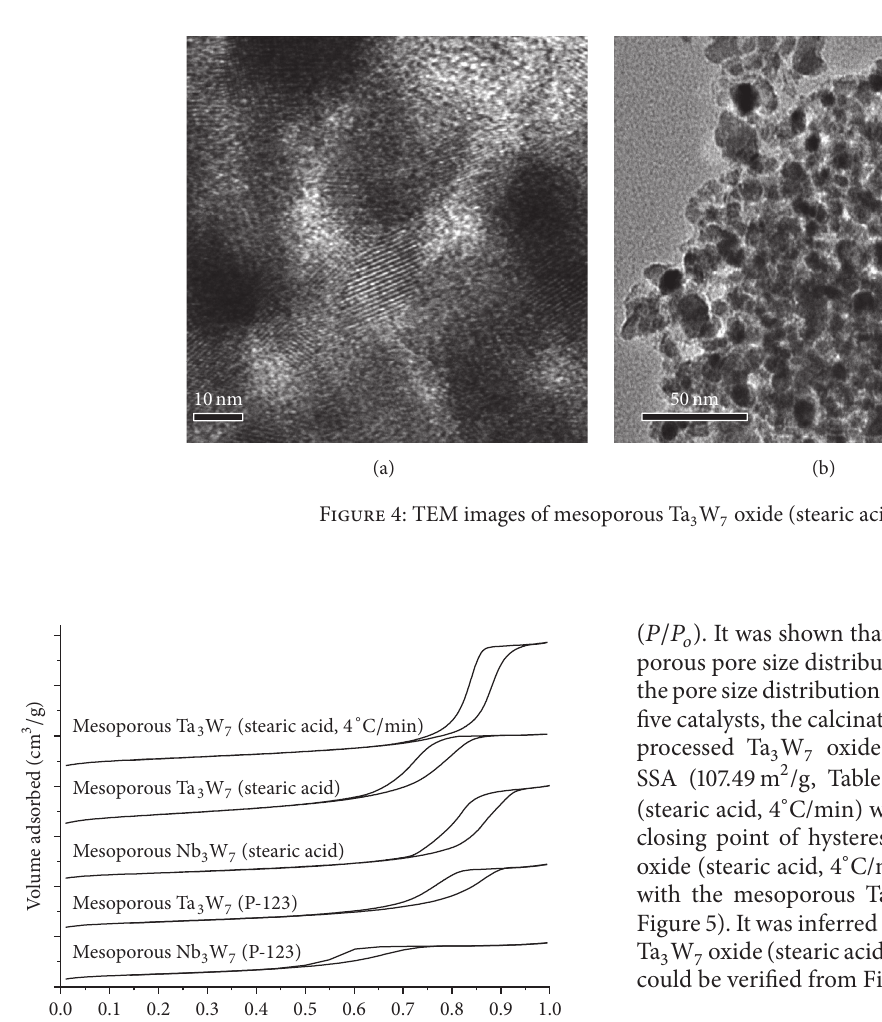
Figure 3: SEM images of mesoporous Ta 3 W 7 oxide (stearic acid).